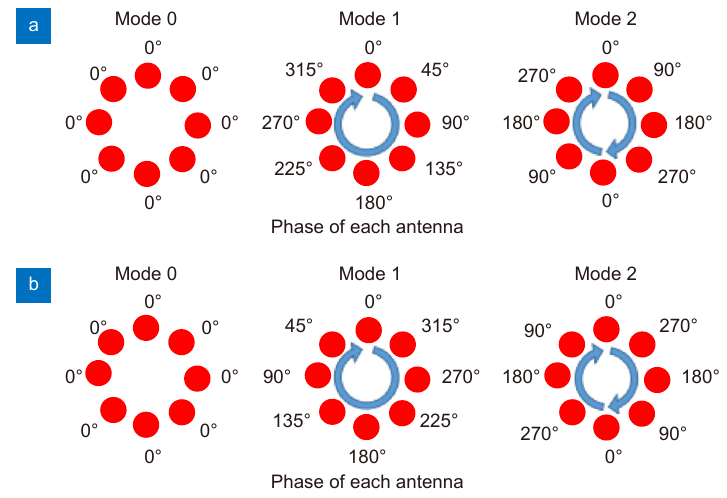
Fig. 12 | ( a ) Formation of OAM modes with a UCA. ( b ) Separation of OAM modes with a